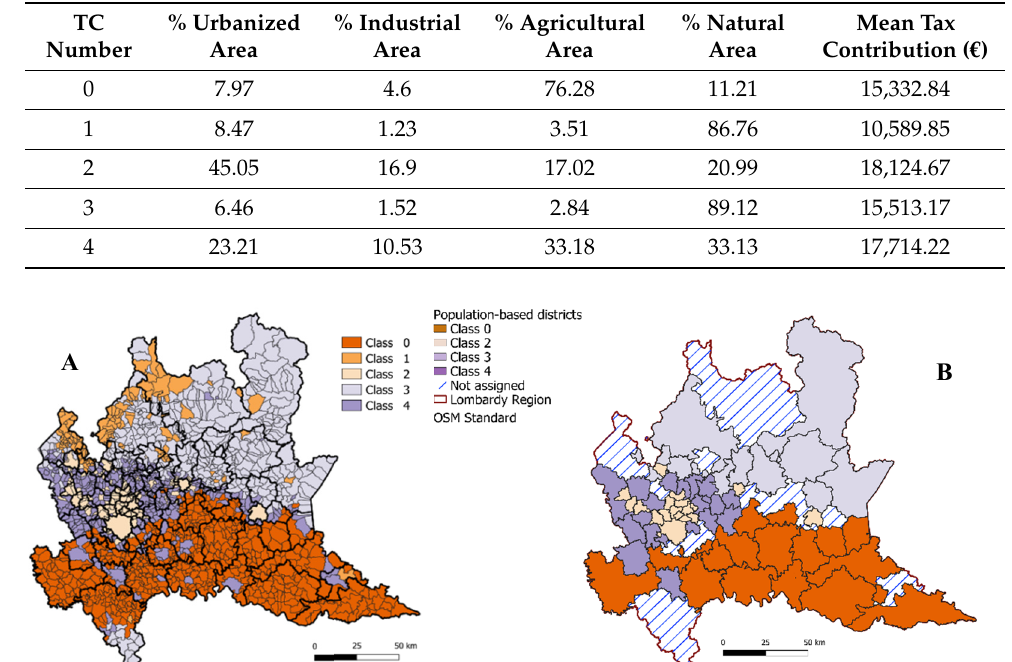
Table 2. Aggregated data distribution, expressed as median (25th–75th percentiles), for the four clustering classes TC (see text for details), reporting the cumulated prevalence of ambulances dispatched (normalized by 100,000 residents) in the considered time period (1 January 2020–23 March 2020), and the values distribution generated by the different districts composing each clustering class, together with the values distribution of all the measurements for each pollutant in the three considered time windows (12 months, 6 months, 1 month).